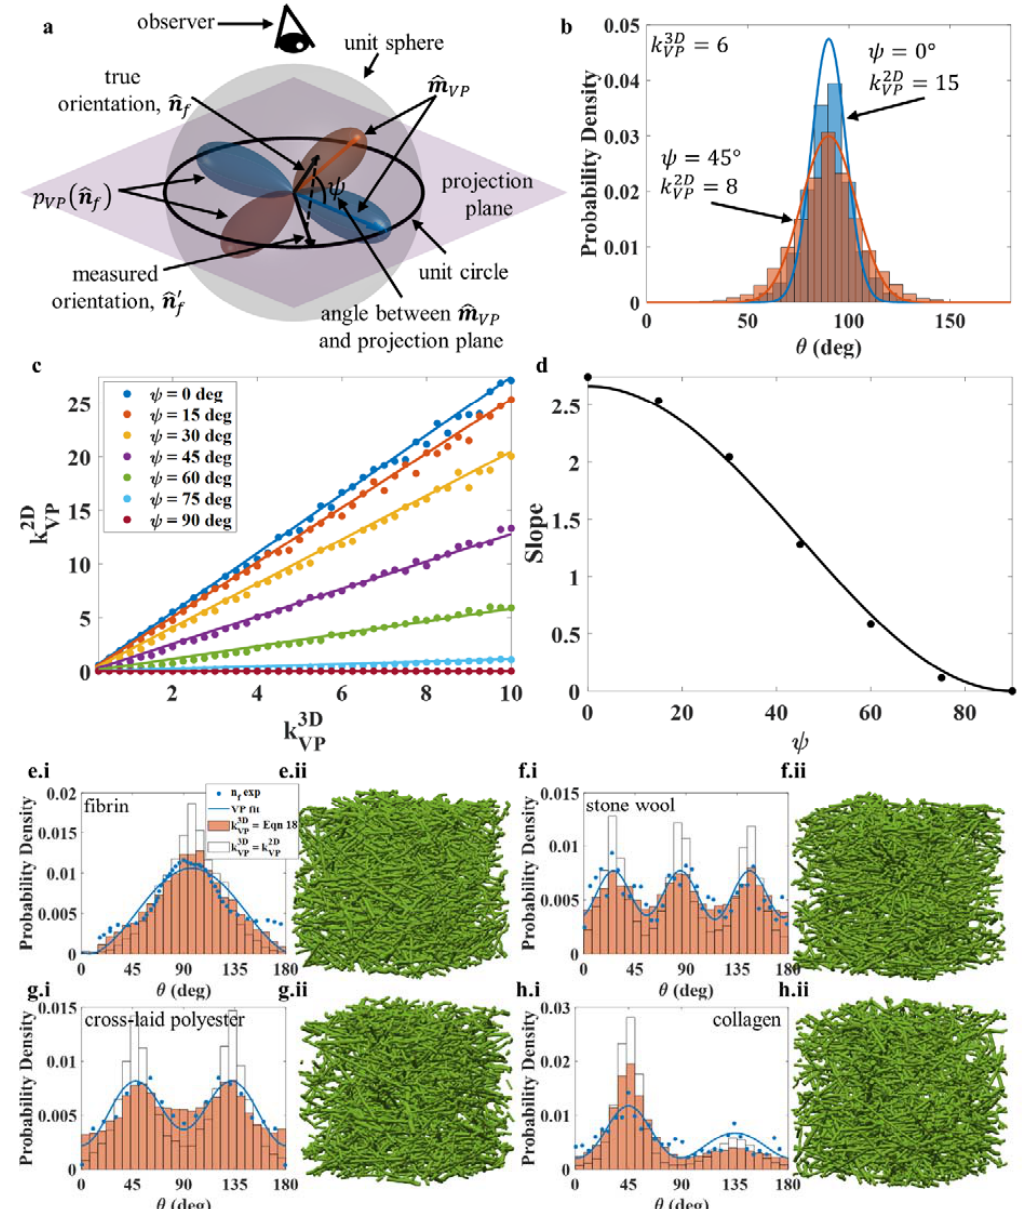
Figure 2. ( a ) Schematic showing two VP distribution functions with identical orientation strength but different rotations with respect to an observer. The schematic also depicts an orientation drawn from either distribution being projected onto a plane from the observer’s perspective. ( b ) Orientation distributions of both VP distribution functions in panel ( a ) after projection and binning. ( c ) The effects of k 3 D and ψ on the measured orientation strength k 2 D . ( d ) The slope of k 2 D vs. k 3 D changes VP VP VP VP with the angle ψ in subfigure ( c ). ( ei – hii ) Curve fitting of empirical histograms and fiber orientation histograms from modeling with and without correcting for projection distortion for ( e.i , e.ii ) fibrin network, ( f.i , f.ii ) stone wool, ( g.i , g.ii ) cross-laid polyester, and ( h.i , h.ii ) collagen. n exp represents the f experimental fiber orientation data; “VP fit” is the regression of Equation (7) to experimental data; the orange histogram is the fiber orientation distribution of simulated FM structures when projection distortion is accounted for; the white histogram is the fiber orientation distribution of simulated FM structures when directly using k 2 D (from regression) as the orientation strength parameter k 3 D (for VP VP drawing random fiber